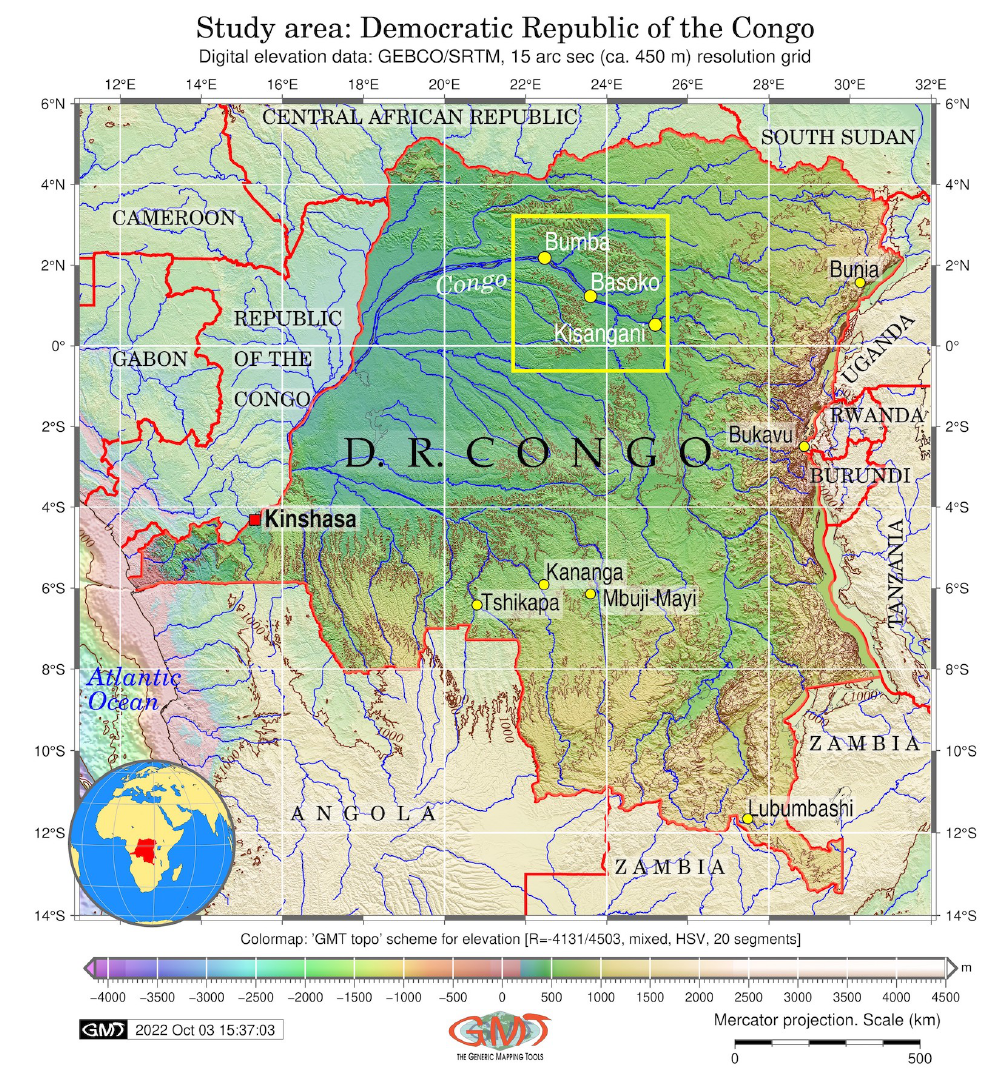
Figure 1. Study area with the location of the three target cities in Congo River Basin, DCR. Cartography: Generic Mapping Tools (GMT). Data source: GEBCO / SRTM. Map source: